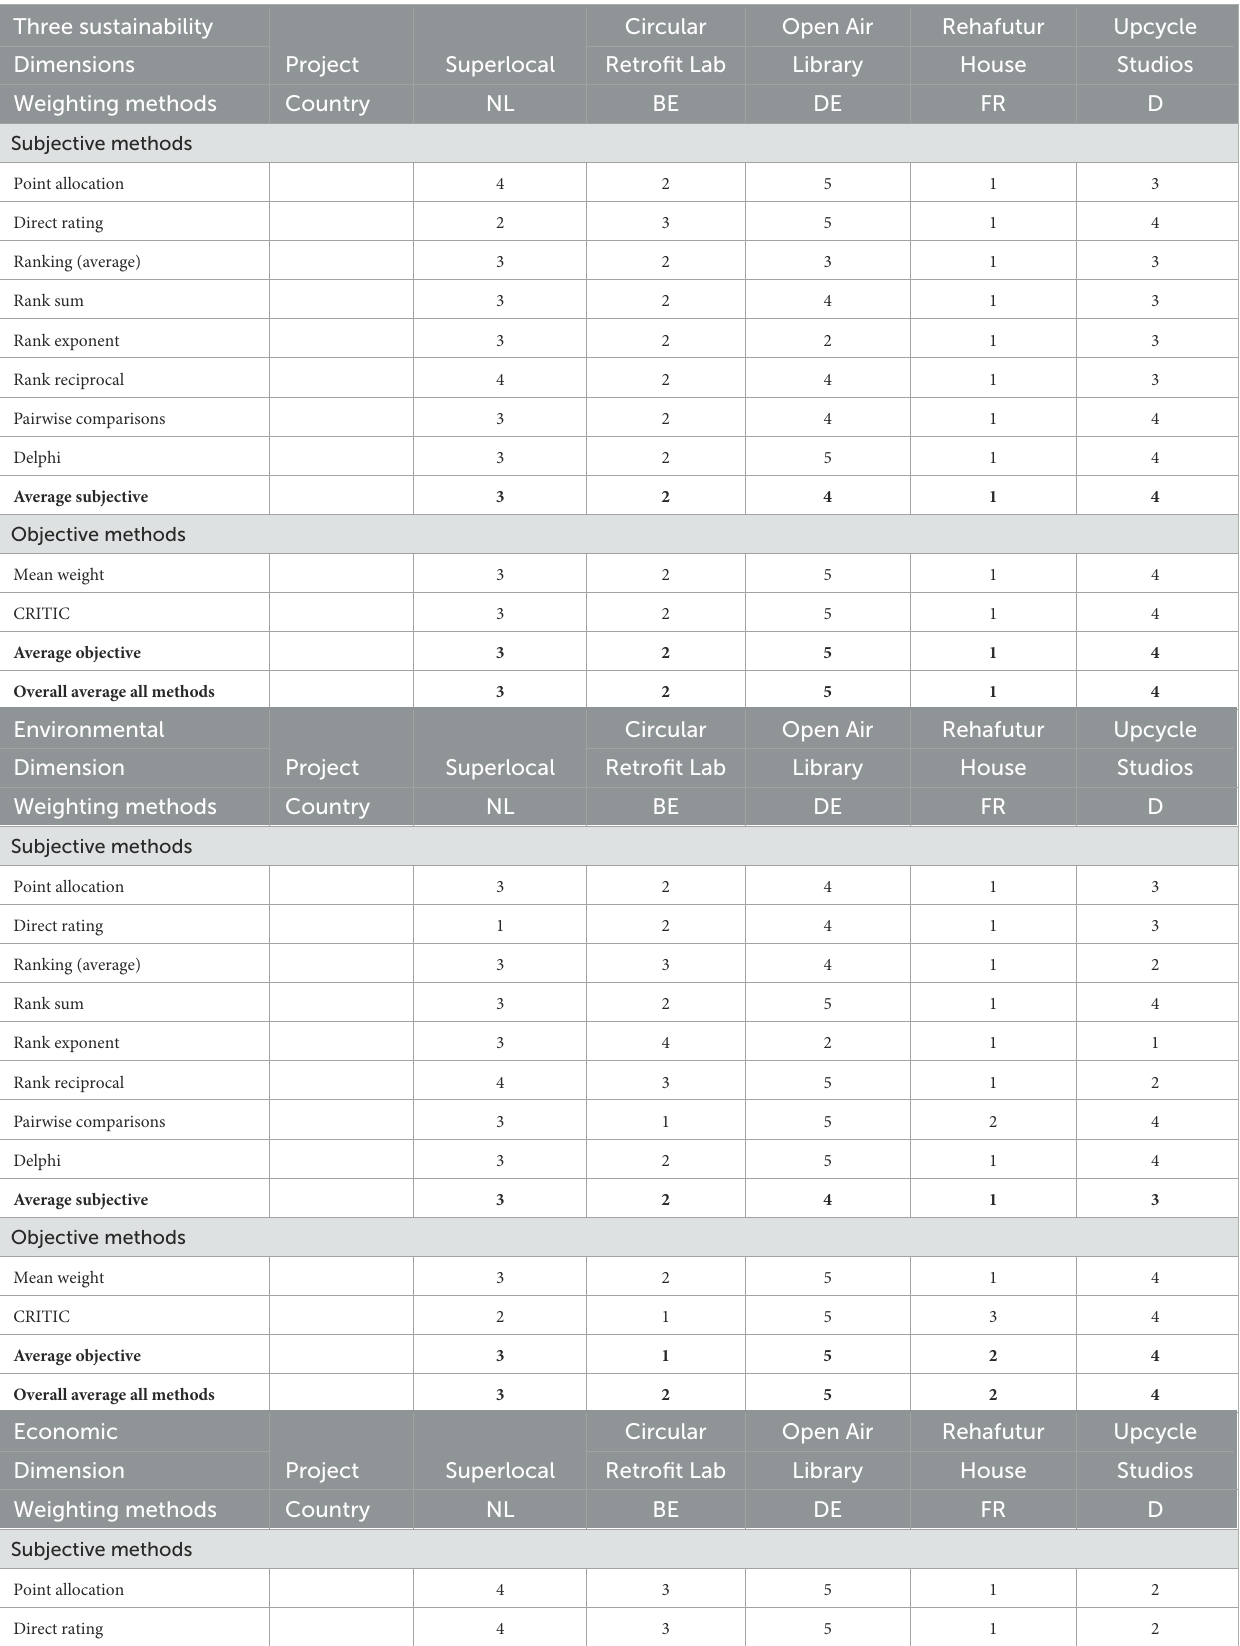
TABLE 7 Comparison of project rankings per weighting method by sustainability dimension. Three sustainability Circular Open Air Rehafutur Upcycle Dimensions Project Superlocal Retrofit Lab Library House Studios Weighting methods Country